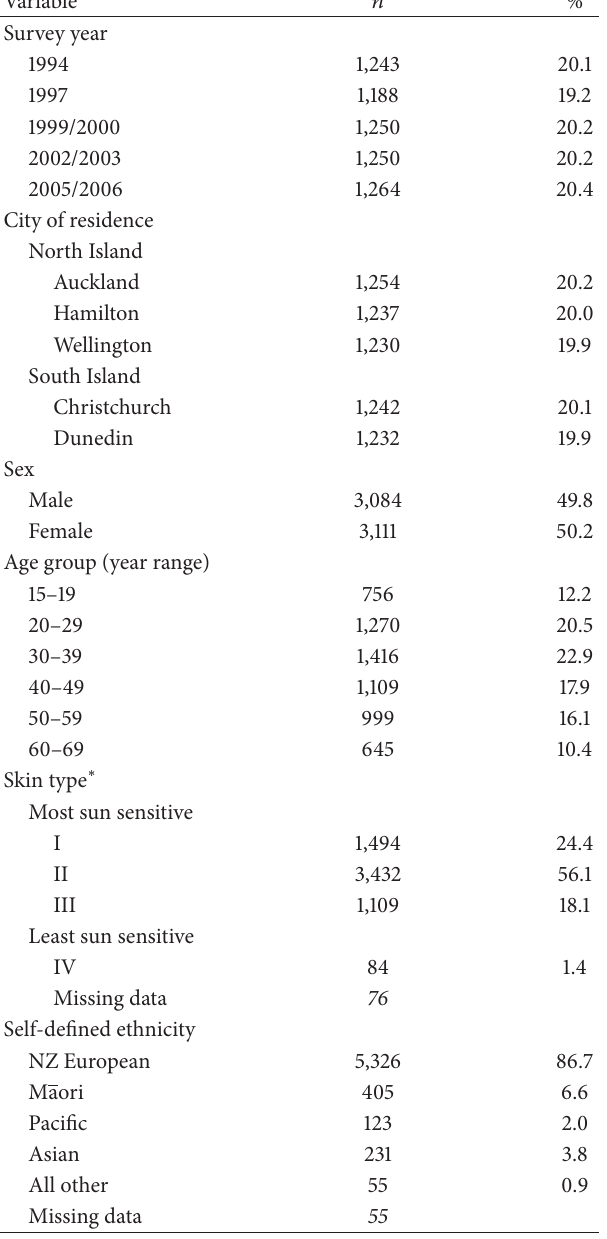
Table 1: Sample demographic and personal characteristics ( 𝑛 =